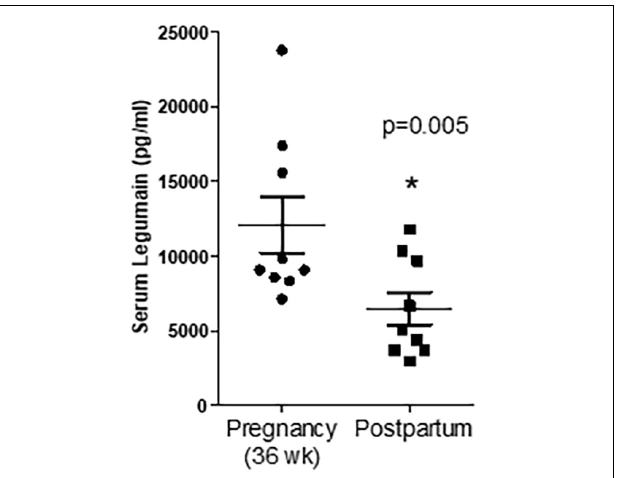
FIGURE 2 | Serum concentration of legumain at 36 weeks of pregnancy and the third week of postpartum. Values are mean + SEM. * P < 0.05 considered significant; Student’s t -test, n = 9/each